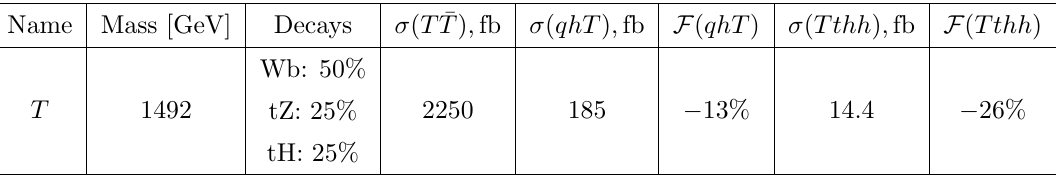
Table 1 . Top partner parameters at the Benchmark Point in the Little Higgs (LH) model.